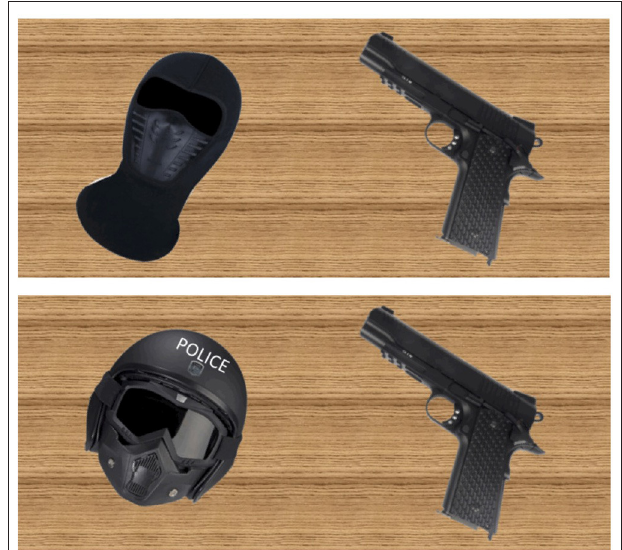
FIGURE 1 | A comparison of a zoomed-in cutscene screenshot showing what participants saw of themselves, that is, assigned gang members and their equipment ( Top image) and assigned police officers and their equipment ( Bottom image). FIGURE 2 | A comparison of a zoomed-in game screenshot showing what